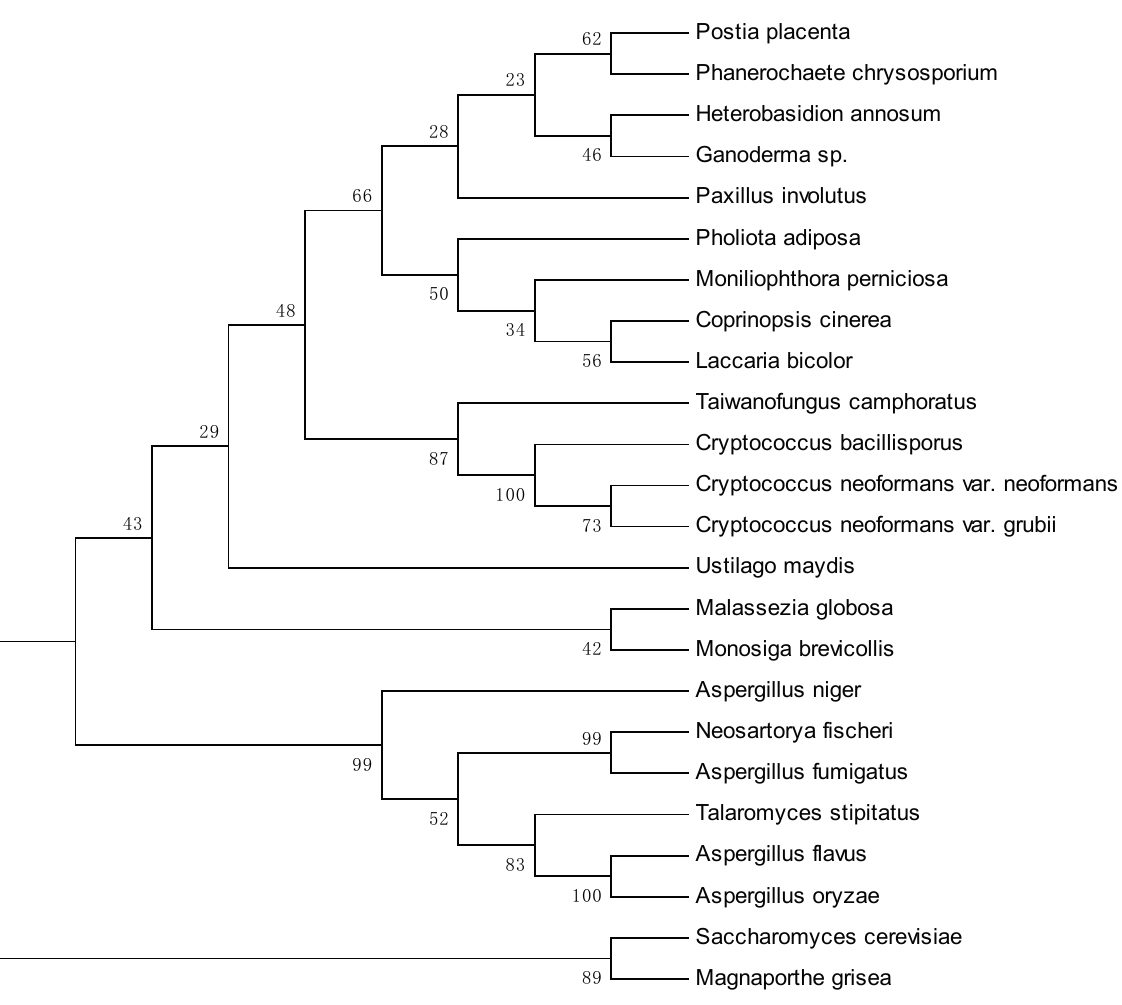
Figure 2. Neighbor-joining tree based on SOD2 gene DNA sequences of 24 species. Bootstrap values (1000 replicates) are shown under the